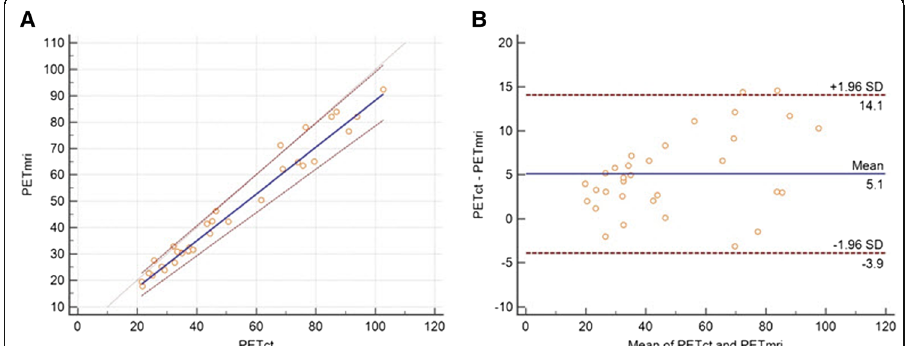
Fig. 3 a The Passing-Bablok regression scatter diagram with the regression line (solid line), the confidence interval for regression line (dashed lines), and identity line ( x = y , dotted line), for mean liver dose values in Gy obtained from both methods and all 32 subjects. PETct denotes mean liver dose in Gy obtained using PET/CT imaging, and PETmri denotes mean liver dose in Gy obtained using PET/MRI imaging ( n =32, ρ =0.97). b Blant-Altman plot for all 32 subjects, with a mean difference of 5.1±5.0 Gy. The repeatability coefficient was 0.15 (12.3% of the